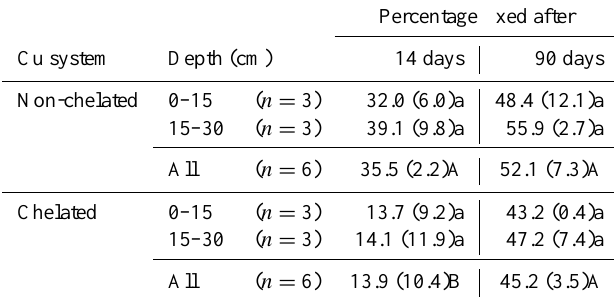
Table 4. Average percentage (with standard deviation) of plant- available copper fixed after 14 and 90 days in the non-chelated and chelated systems of the semiarid alkaline soils of the Southern High Plains,